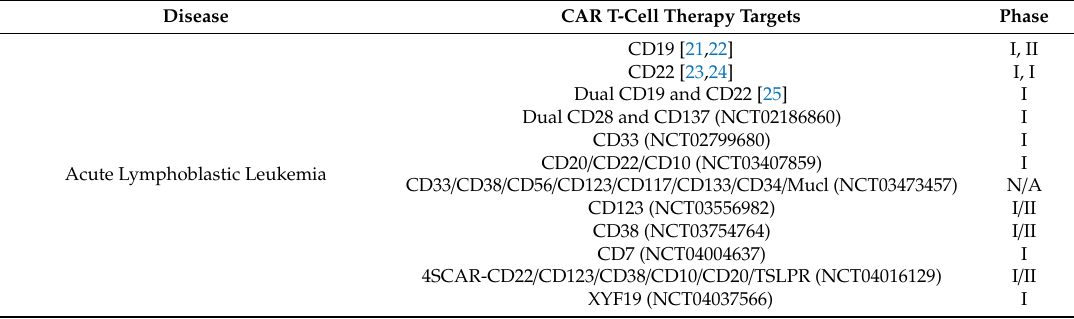
Table 1. Current CAR T-cell therapy targets in hematological